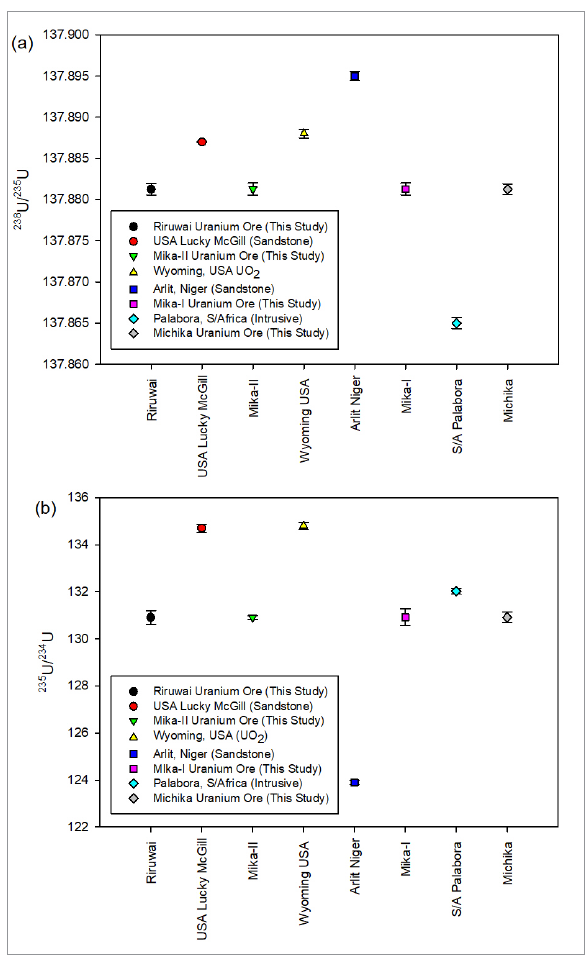
Figure 3: Comparison of uranium isotopic ratios (a) 238 U/ 235 U and (b) 235 U/ 234 U from our study sites and other parts of the world. Uranium age determination